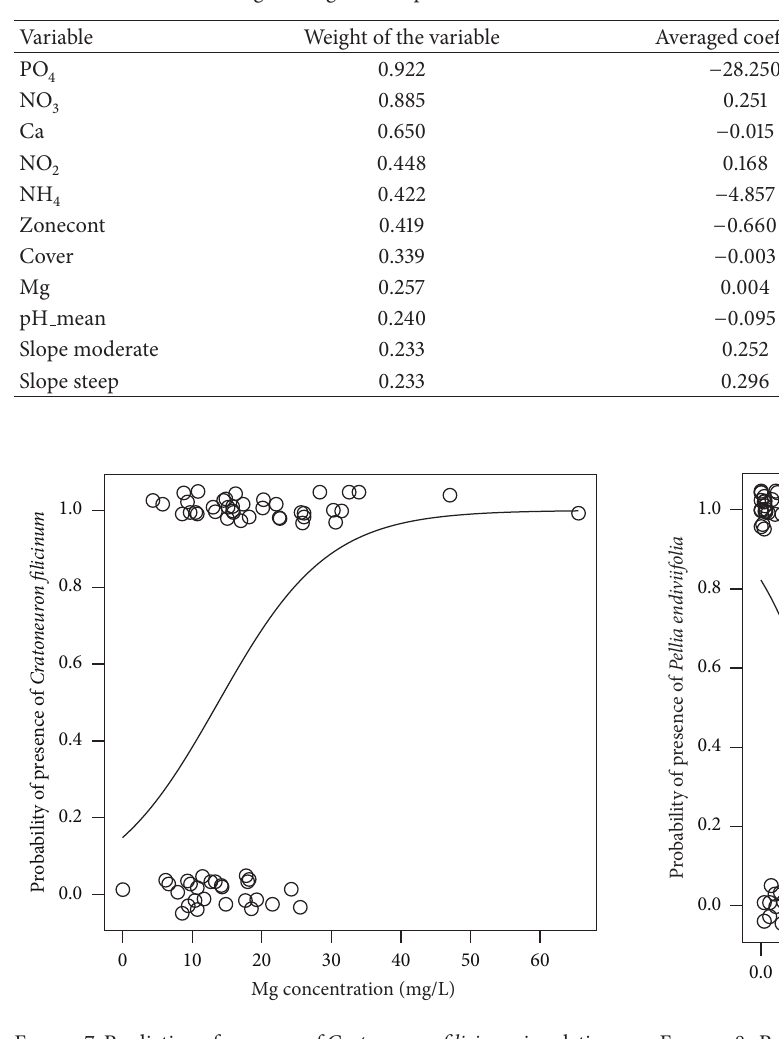
Figure 8: Prediction of presence of Pellia endiviifolia in relation to PO 4 concentration based on the coefficients of the best models selected by AIC stepwise selection with the full